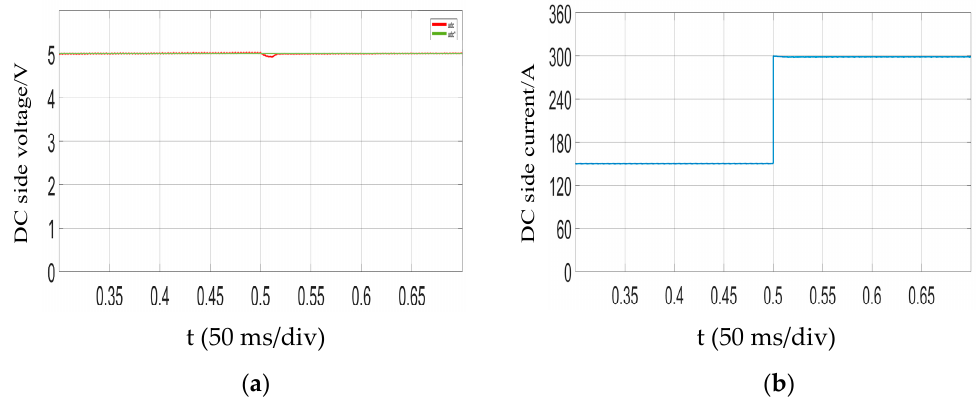
Figure 7. Simulated waveform of DC output when the load suddenly decreases: ( a ) DC output voltage waveform; ( b ) DC output current waveform.